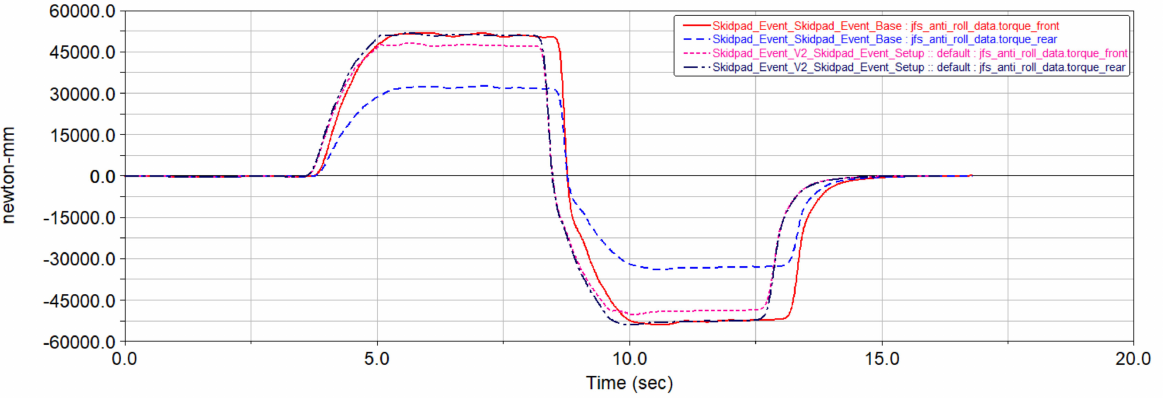
Figure 22. Skidpad Event-Antiroll reactions comparison.